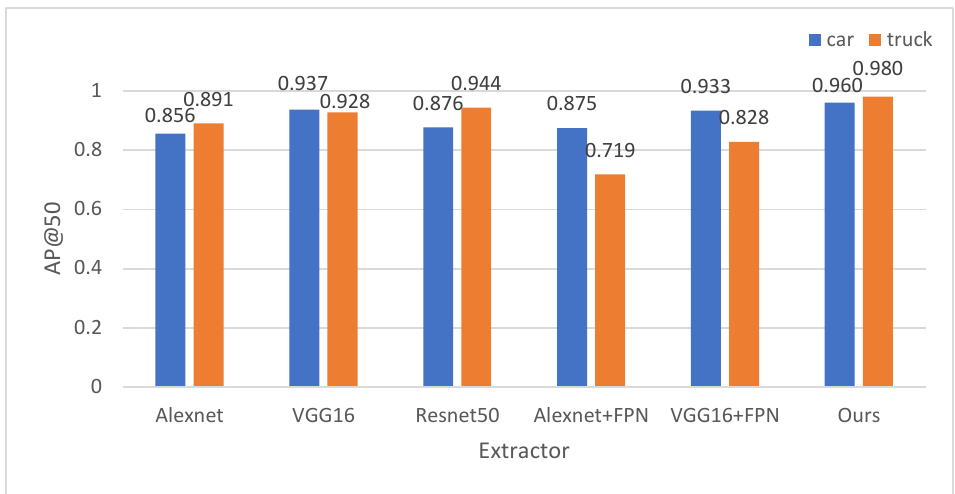
Figure 14. Detection results obtained by using multi-scale Faster-RCNN on eight frames.